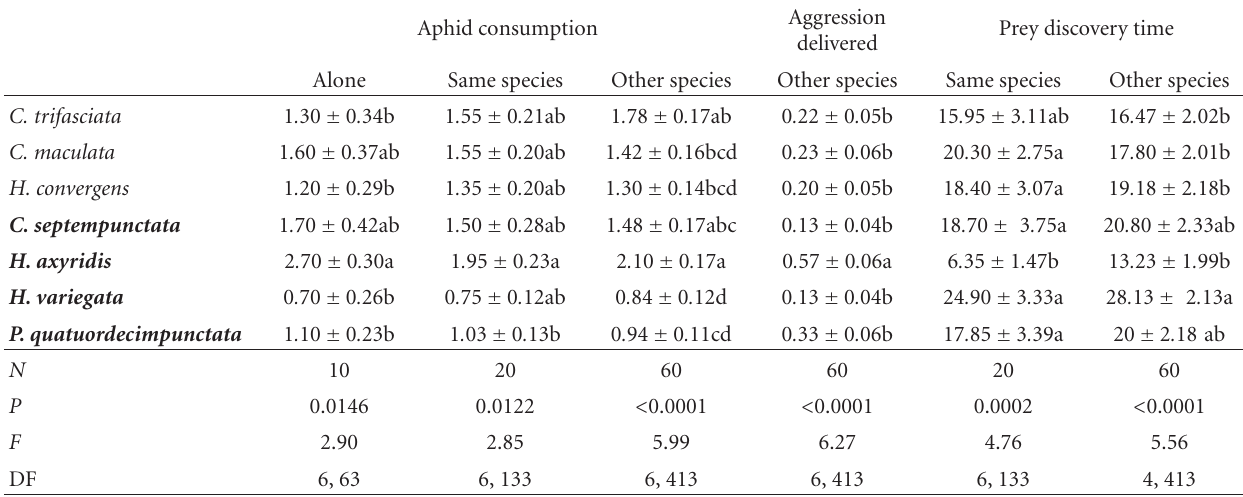
Table 1: Mean ( ± SE) aphid consumption (number of aphids), prey discovery time (minutes), and aggression delivered (number of occur- rences) by seven lady beetle species during laboratory trials. The data were pooled for all trials conducted with a given species (see text for details). Means in each column followed by the same letter are not significantly di ff erent from each other (Tukey’s HSD tests, P < 0 . 05). Nonnative species are printed in bold font.